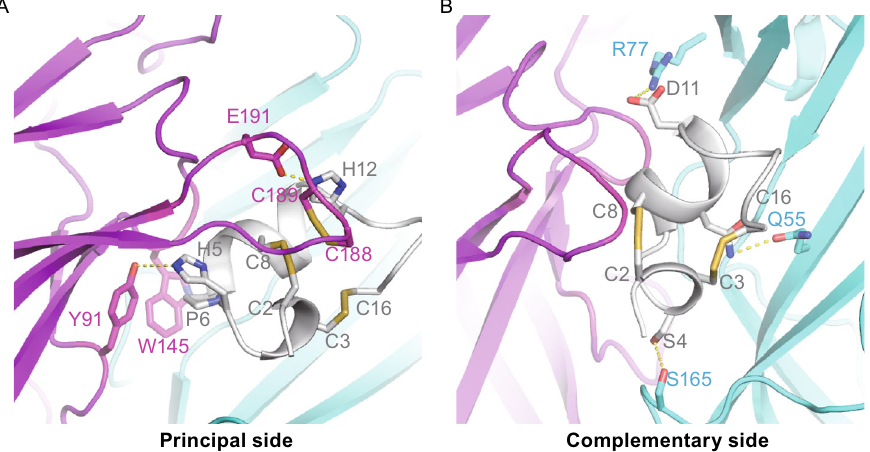
Figure 2. Binding interface between α -conotoxin LvIA and Ac-AChBP. (A) The disul fi de bridge packing and hydrogen-bonding interactions (represented by yellow dashed line) on the principal side. Residues His-5 and His-12 of the LvIA form hydrogen bonds with Tyr-91 and Glu-191 of the Ac-AChBP, respectively. Disul fi de bond C2-C8 in the LvIA closely packed together with C188-C189 in the Ac-AChBP. (B) On the complementary binding side, Ser-4 and Asn-9 of LvIA forms a hydrogen bond (represented by yellow dashed line) with Ser-165 and Gln-55 of Ac-AChBP, respectively. Electronic interaction was also observed between Asp-11 of LvIA and Arg-77 of